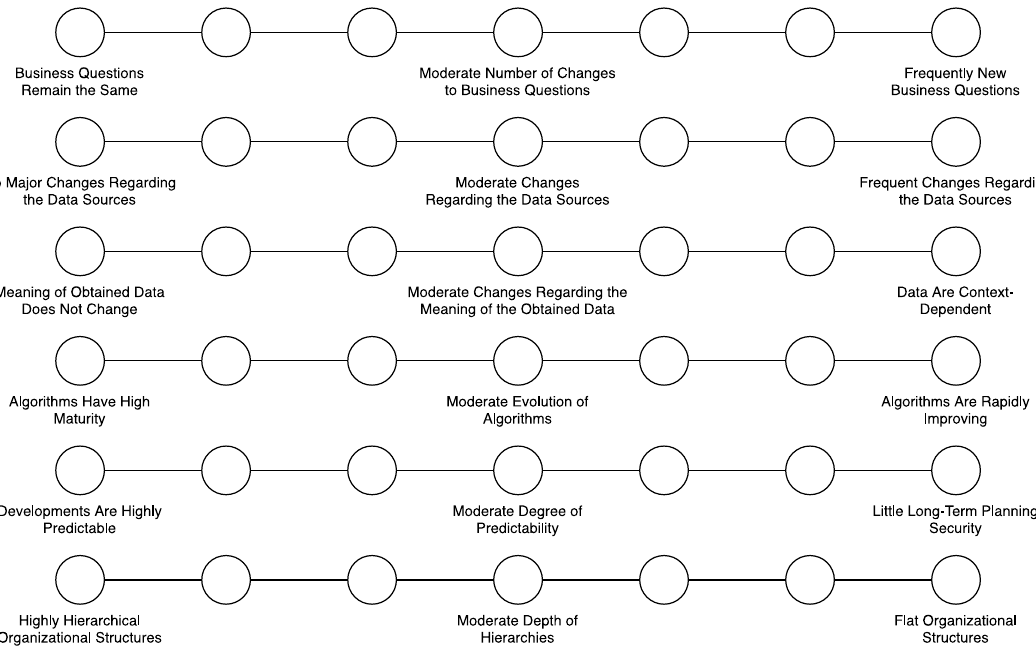
Figure 4. Survey to determine the degree of stability and dynamism